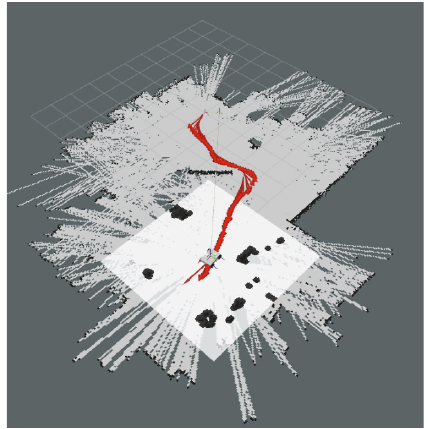
Figure 10: Path planning in unknown